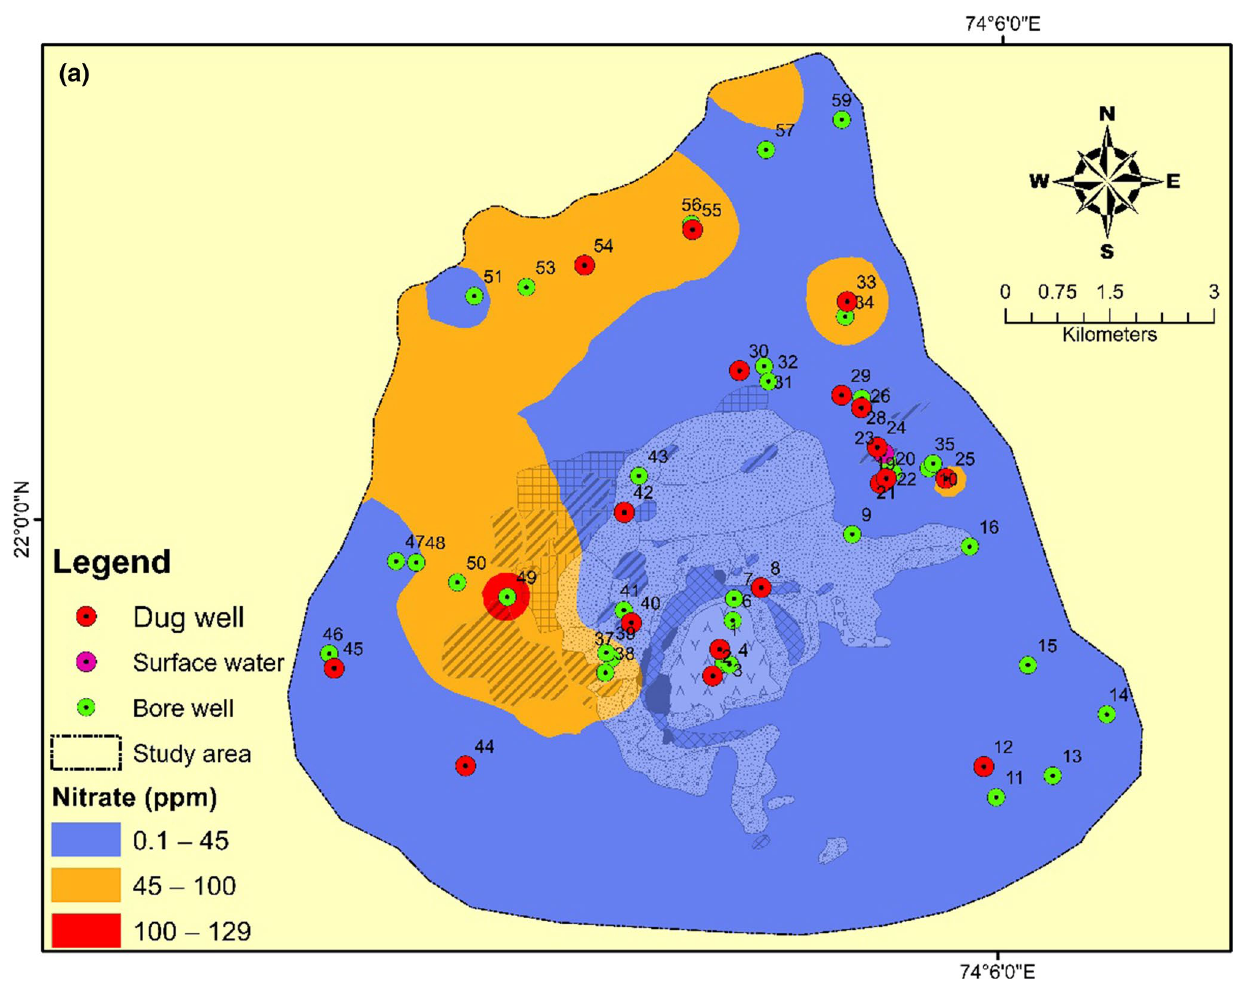
Fig. 4 a Nitrate distribution map in POM 2014. b Nitrate distribution map in PRM